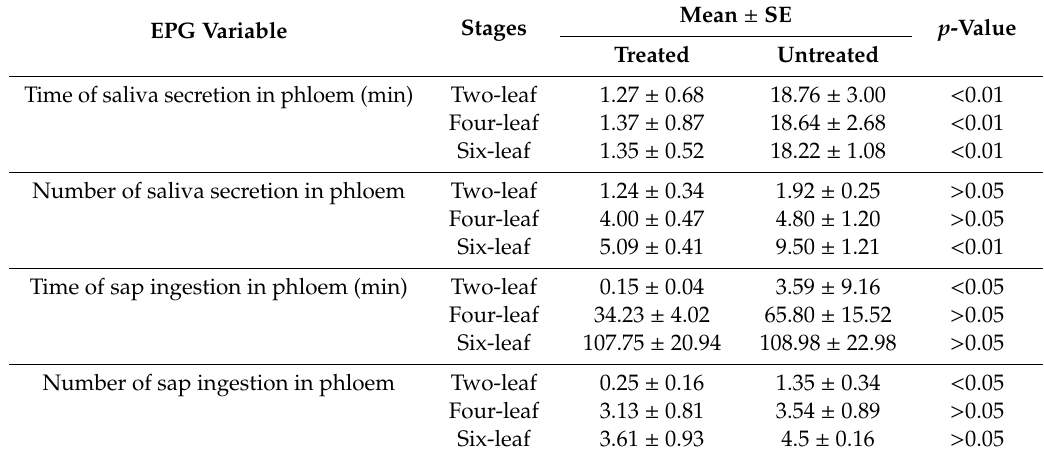
Table 2. Effect of imidacloprid seed treatments on aphids’ feeding behaviors in phloem-associated elements.